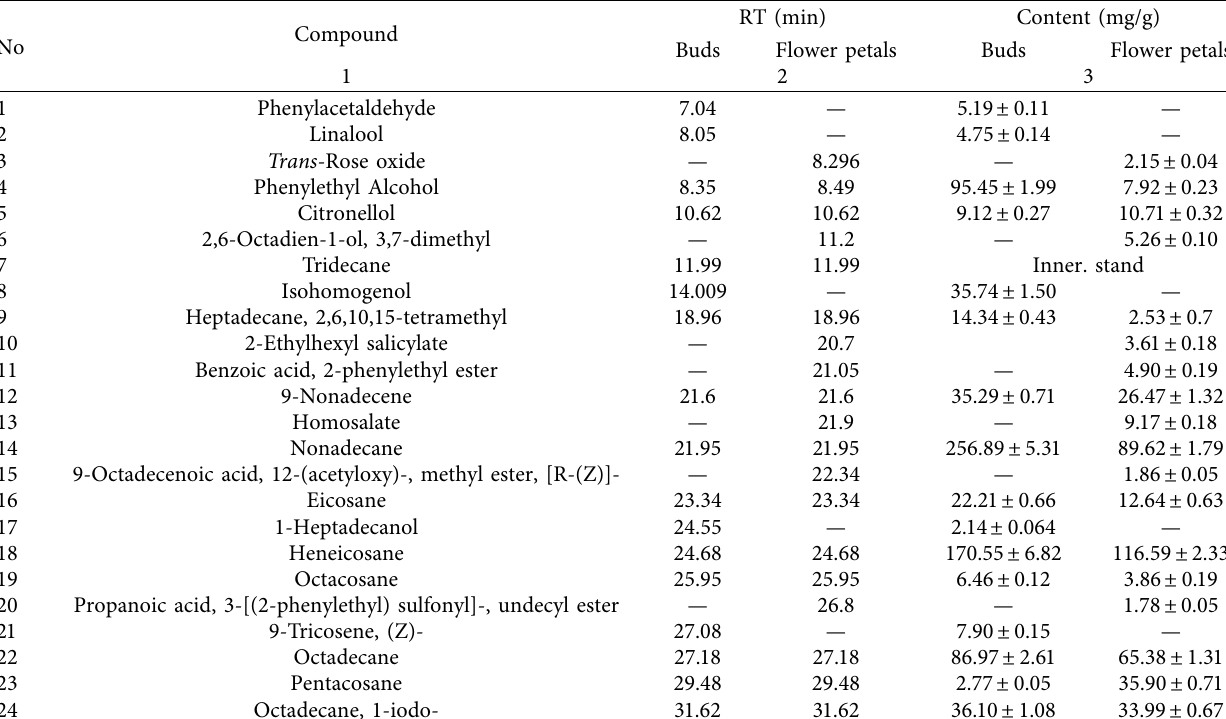
Table 3: Volatile compounds in medicinal plant material of R.